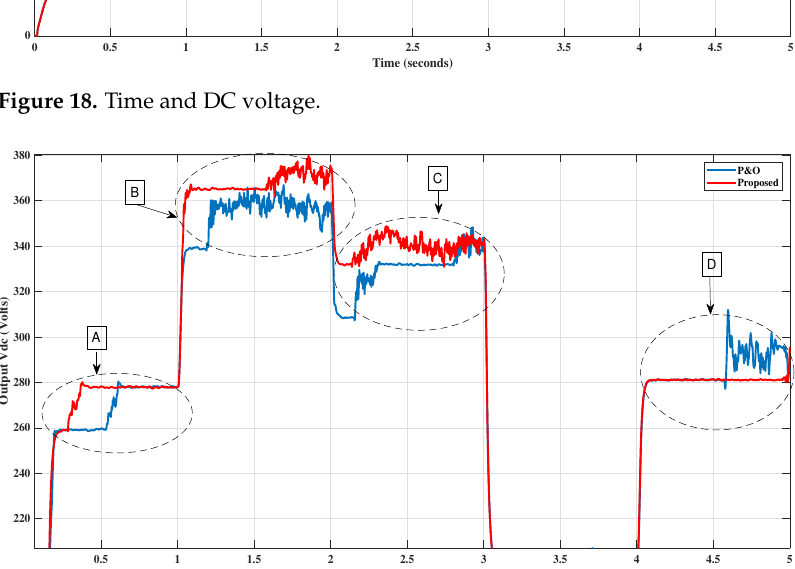
Figure 19. Time and output DC voltage—zoomed sections. At wind speeds of 10 m/s, 12 m/s, and 11 m/s denoted by sections A, B, and C, the voltage obtained for the proposed algorithm is considerably greater than that obtained for the CPO method.